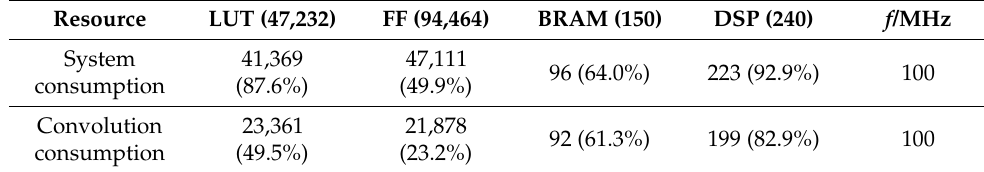
Table 1. Resource consumption of FPGA.